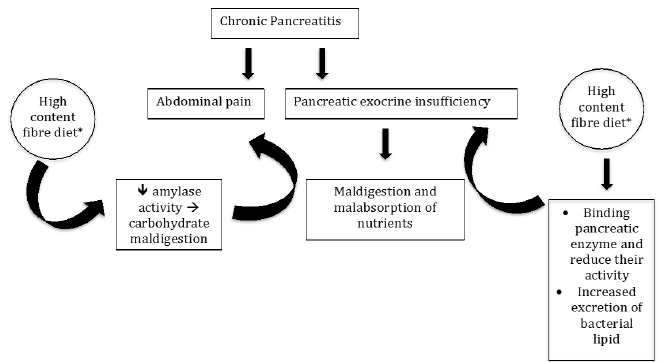
Figure 1. Interaction between high content fibre diet* and pancreatic enzymes in chronic pancreatitis. * High content fibre diet: > 25 g / day in women, > 38 g / day in men